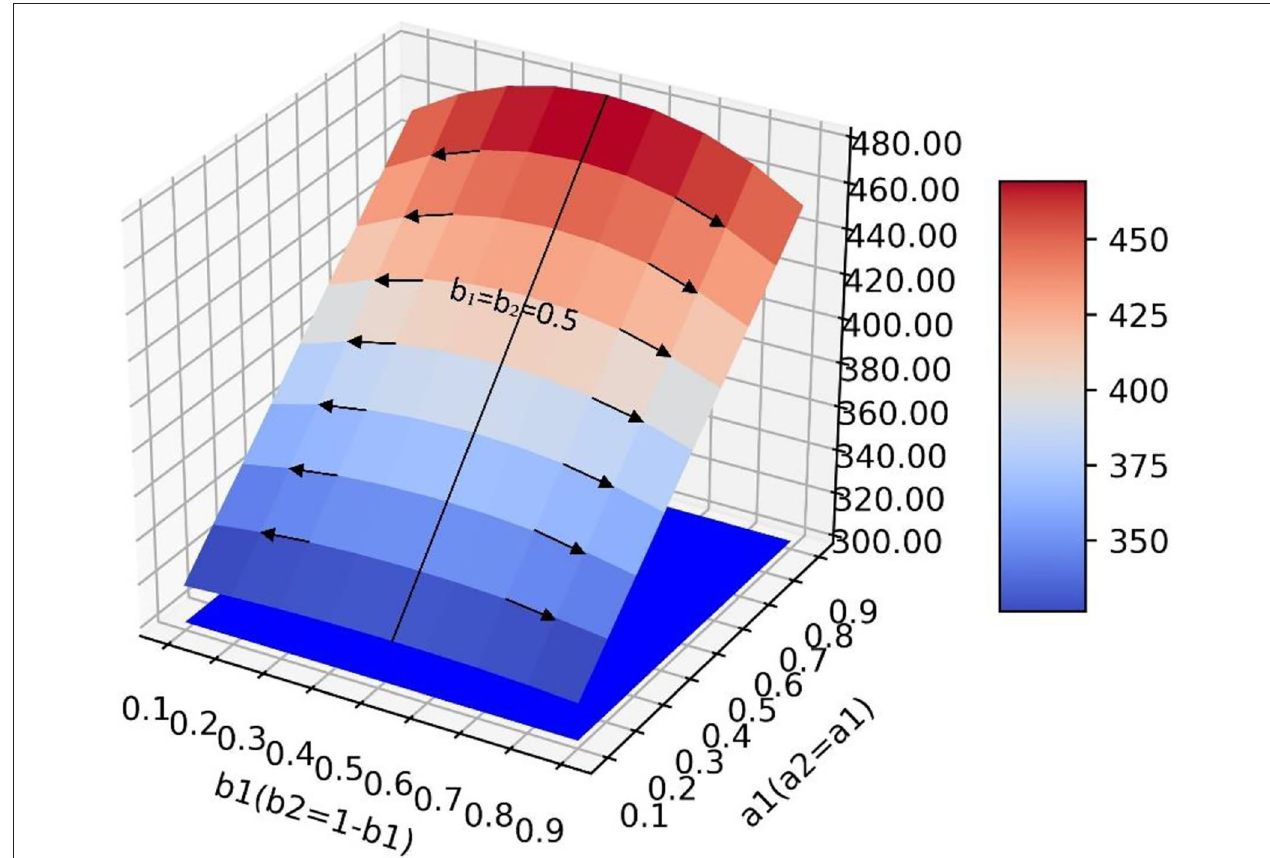
FIGURE 8 | In the scene of simulation 2, the local optimal value of Y.